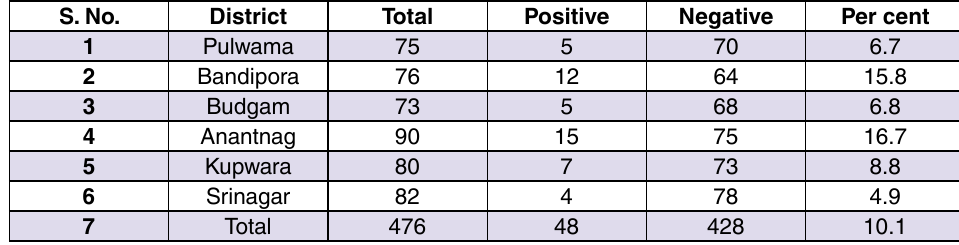
Chi-Sq = 11.446, DF = 5, P-Value = 0.043 of Echinococcosis infection in stray dogs of different districts in the Kashmir valley. The results were considered statistically significant when the p-value was <0.05.